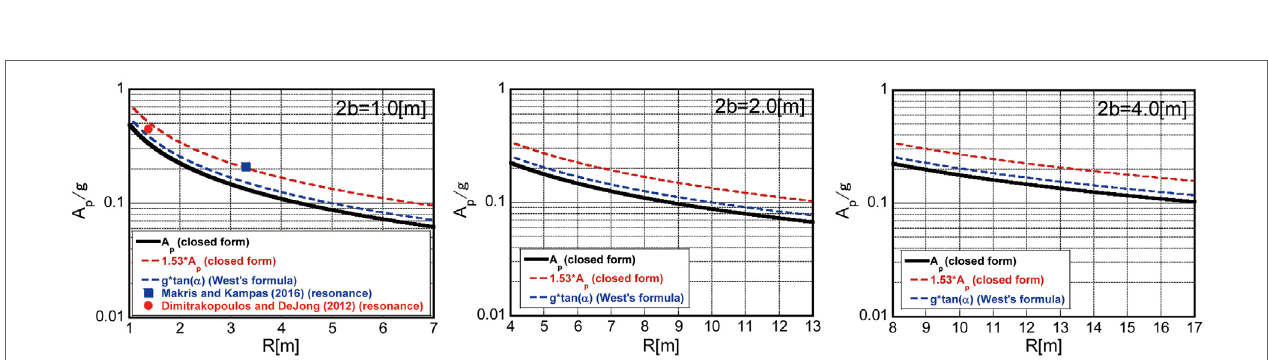
FigUre 10 | critical acceleration amplitude ratio of equivalent one-cycle sinusoidal input to acceleration of gravity for 2 b = 1, 2, and 4 m and comparison with other results .